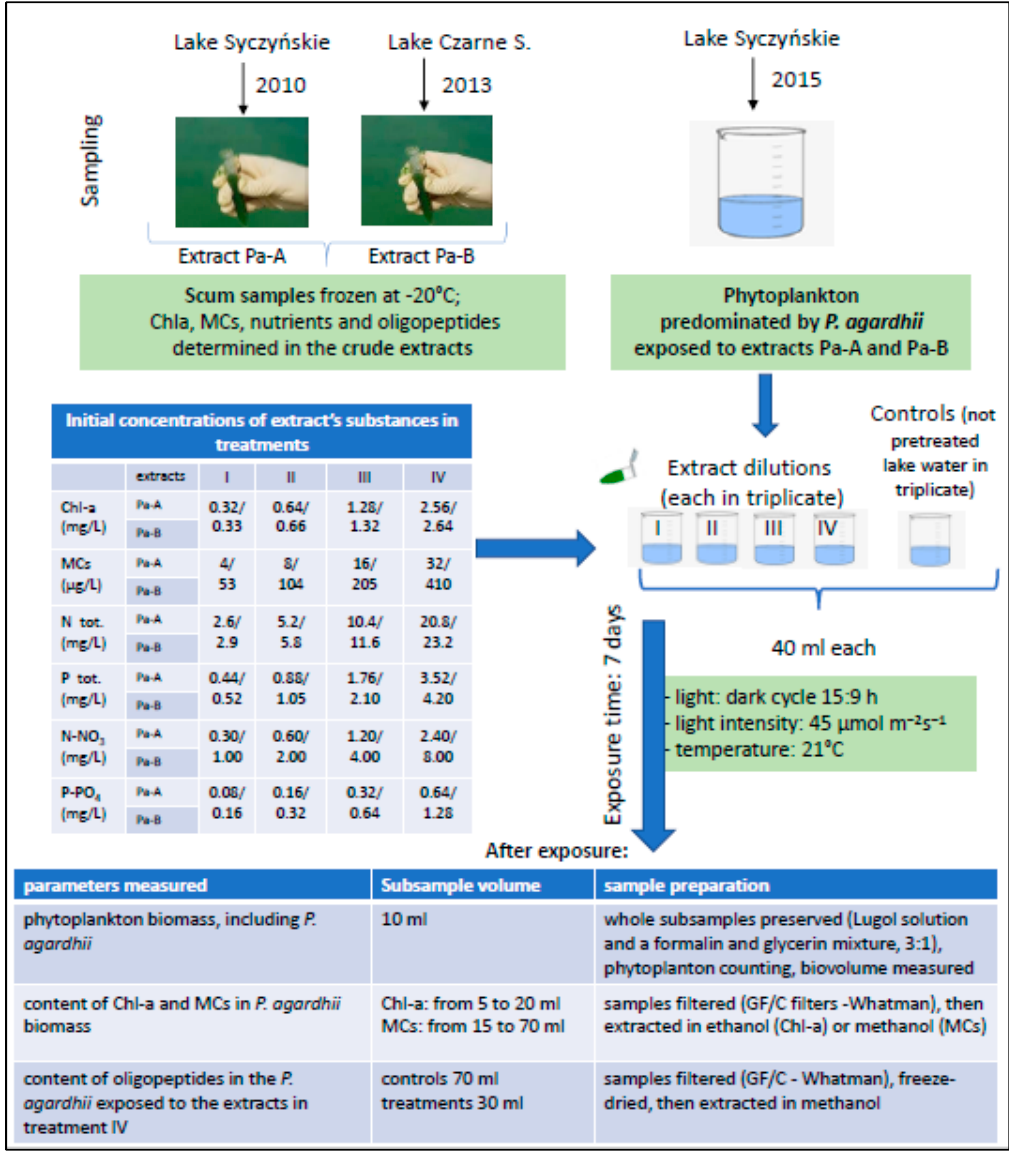
Figure 1. Experimental design and conditions.